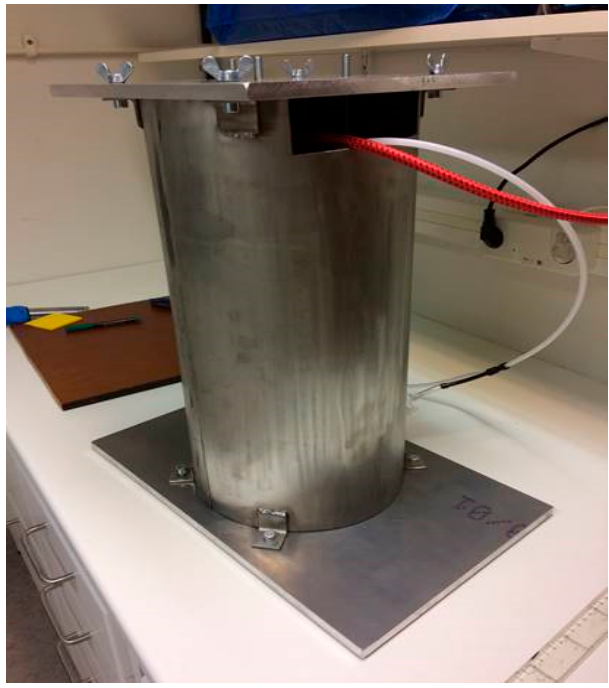
Figure 16. The metal encasement arrangement.